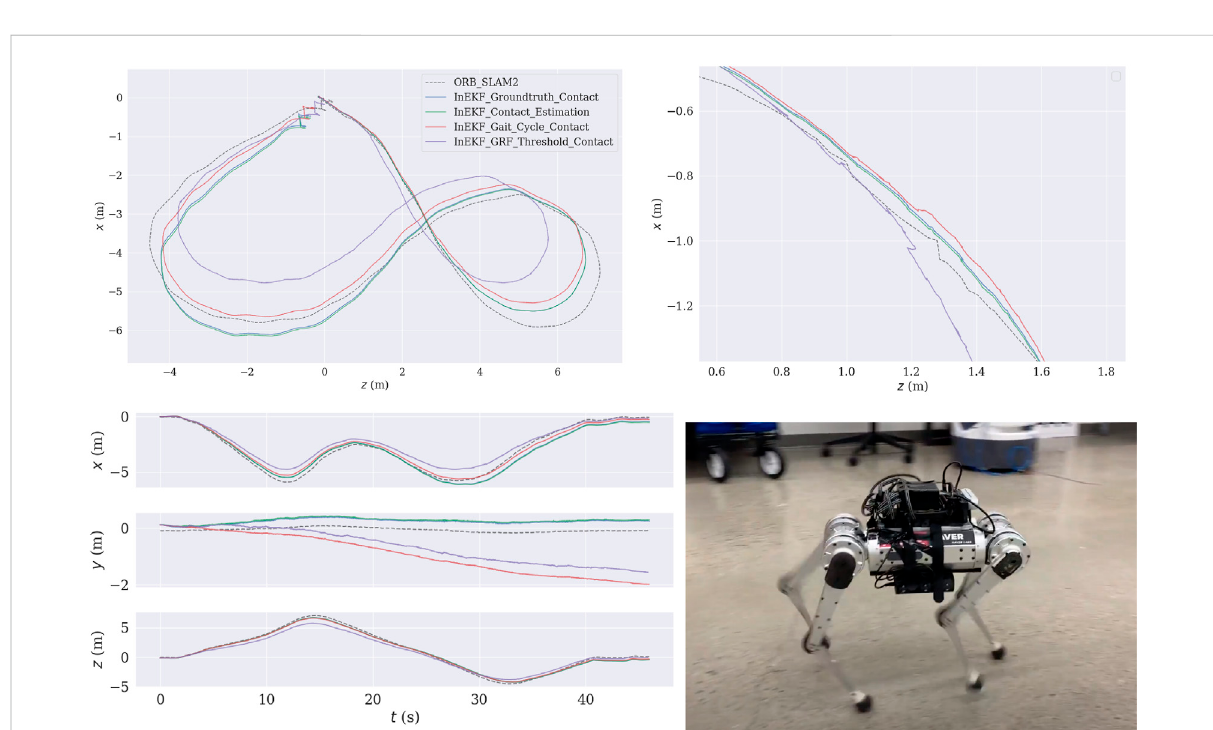
FIGURE 6 Concrete short looptestsequence.TopLeft:The bird ’ s-eyeviewofthetrajectories.Theestimatedtrajectory ismappedtothecameraframe( Y pointingdownward,and Z pointingforward).TopRight:Zoomed-inofthebird ’ s-eyeview.BottomLeft:This fi gureshowsthatthegaitcycleandGRF thresholding methods produce a signi fi cant height (Y) drift. Bottom Right: Robot con fi guration.